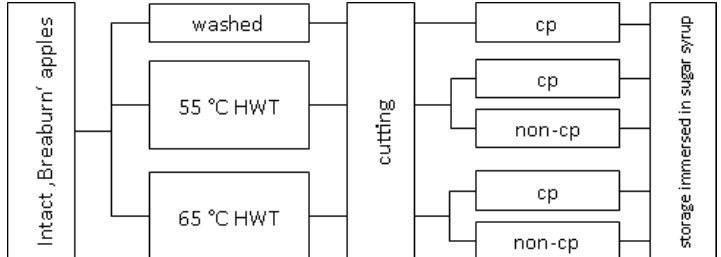
Figure 1. Scheme of the various pre- (short-term hot-water, sHWT, vs. washed) and post-cutting (chemical prevention, cp, vs. no chemical prevention, non-cp) treatments of fresh-cut apples slices stored in sugar syrup at 4 °C for up to 13 d.